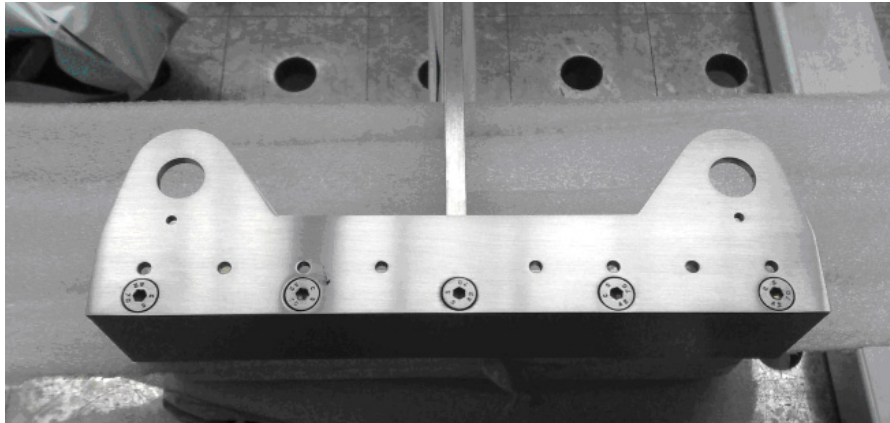
Figure 3: Production of the stainless steel connectors of the glass balustrade